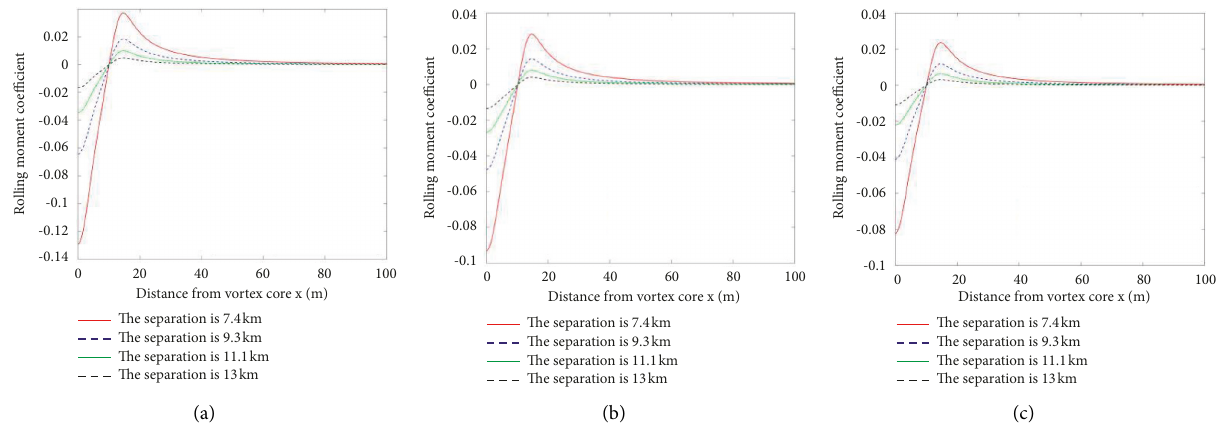
Figure 11: Variation of rolling moment coefficient with distance from vortex core when encountering single vortex. (a) Takeoff phase. (b) Level flight phase. (c) Landing